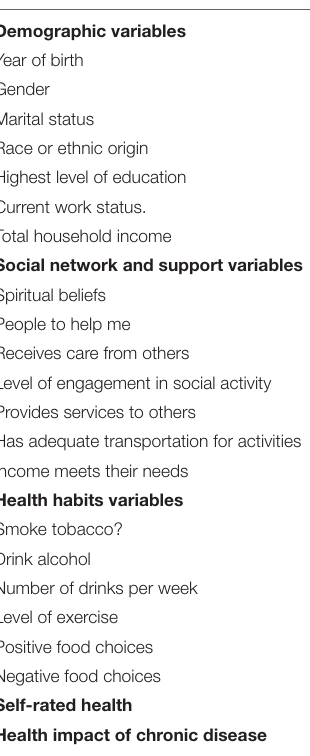
TABLE 2 | Personal health survey